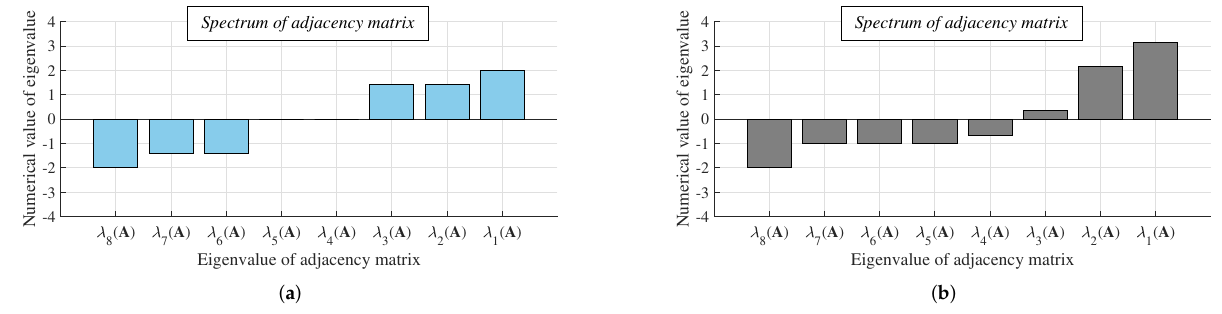
Figure 9. Spectrum of adjacency matrix of bipartite regular connected graph and non-bipartite non-regular connected graph formed by eight vertices − example. ( a ) Bipartite regular connected graph. ( b ) Non-bipartite non-regular connected graph.